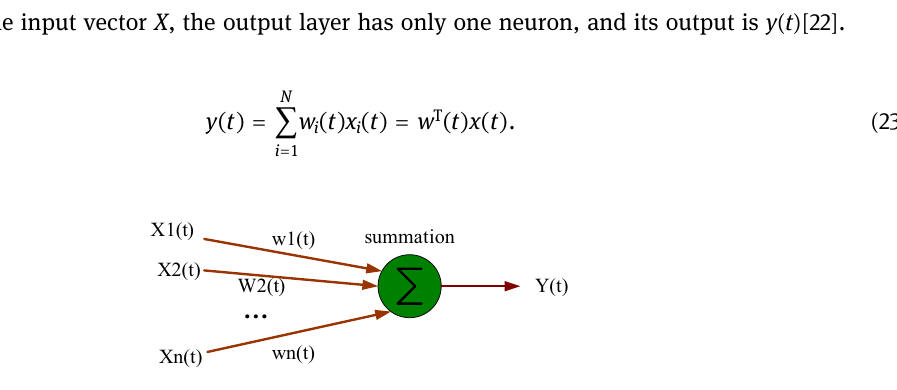
Figure 5: Oja neural network